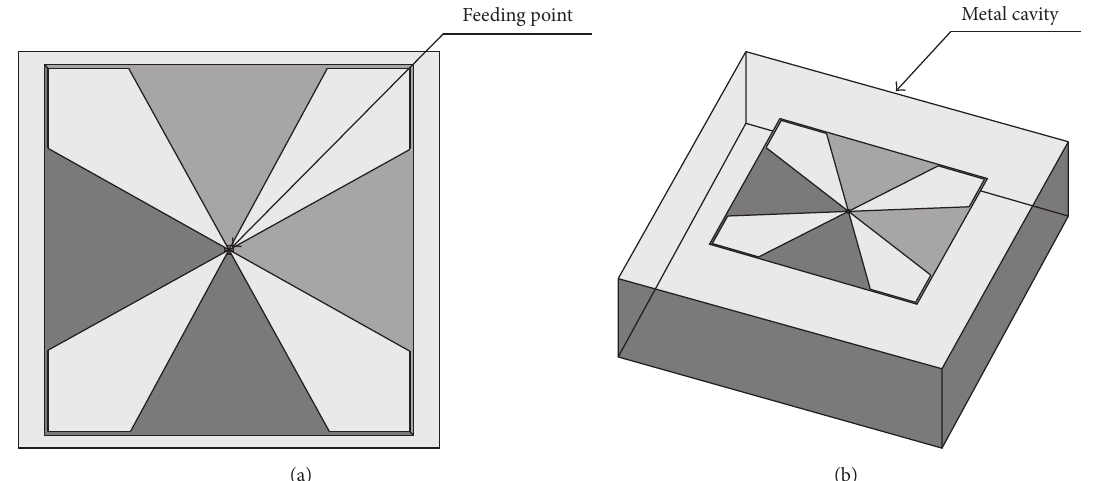
Figure 37: Geometry of a dual polarized wideband directional coupled sectorial loop antenna [56]. Top view (a) and tridimensional view